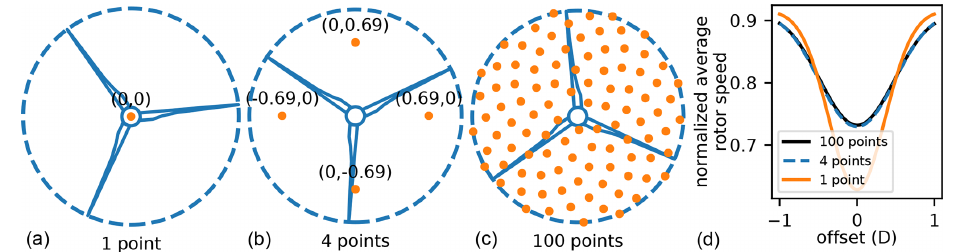
Figure 6. The sample points used to calculate the average wind speed into a turbine. (a–c) From left to right, the location of the 1, 4, and 100 sample points is shown on the swept area of the rotor. (d) The average rotor speed of a turbine moving across the wake of an upstream turbine. The downstream turbine moves from one side of the wake ( − 1 D offset) to the other side of the wake (1 D offset). Each of the three lines shows the average rotor wind speed calculated with 1, 4, and 100 sample points.